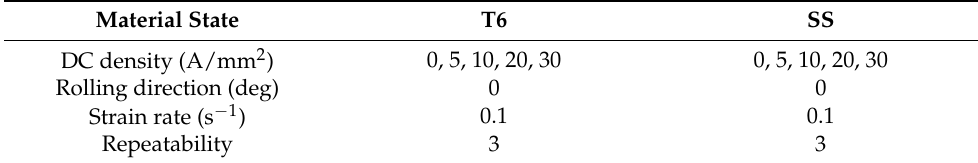
Table 3. Experimental plan of the tensile